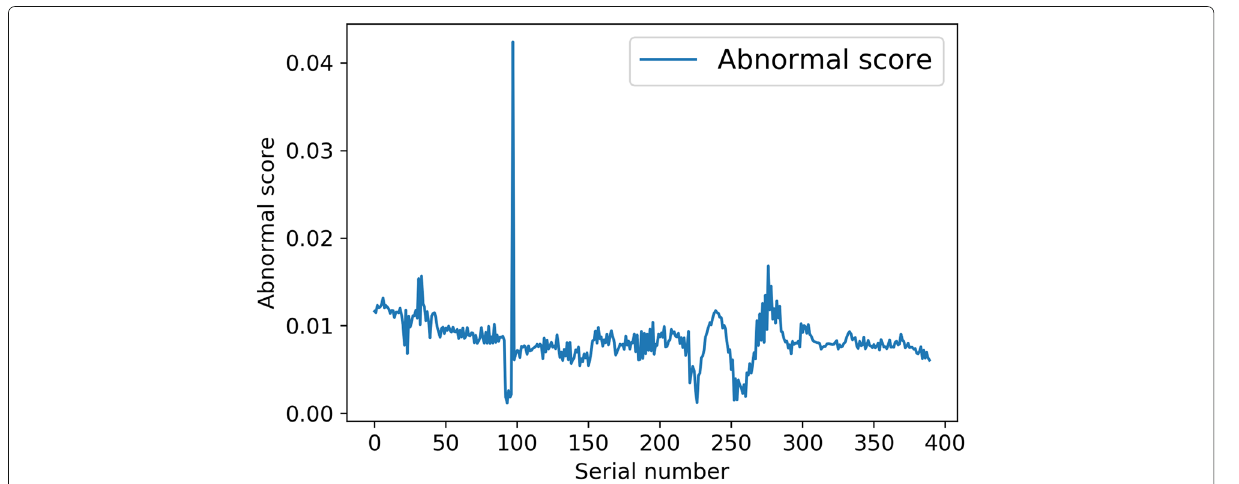
Fig. 11 Partially enlarged view of latitude